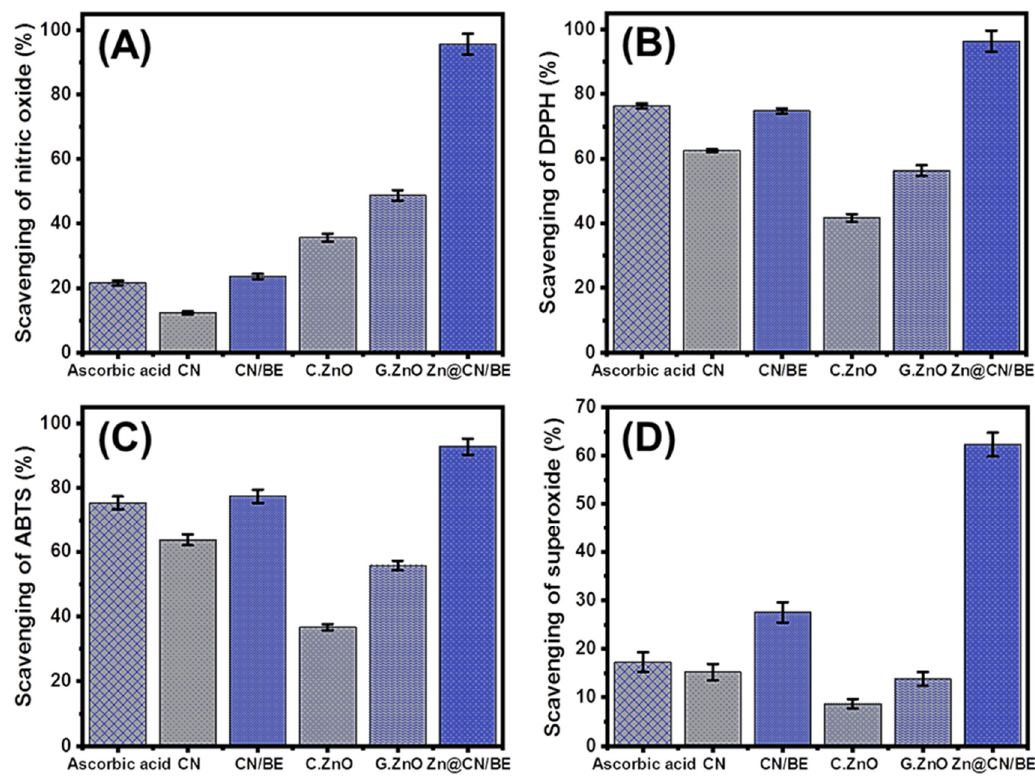
Figure 4. The antioxidant activities of CN, CN/BE, commercial ZnO, green ZnO, and Zn@CN/BE structures (100 μ g/mL) (the tests were replicated 5 times); ( A ) Nitric oxide scavenging activities (20 μ L; 100 μ g/mL); ( B ) DPPH scavenging activities (20 μ L; 100 μ g/mL); ( C ) ABTS scavenging activities (10 μ L; 100 μ g/mL); and ( D ) superoxide radical scavenging activities (100 μ L; 100 μ